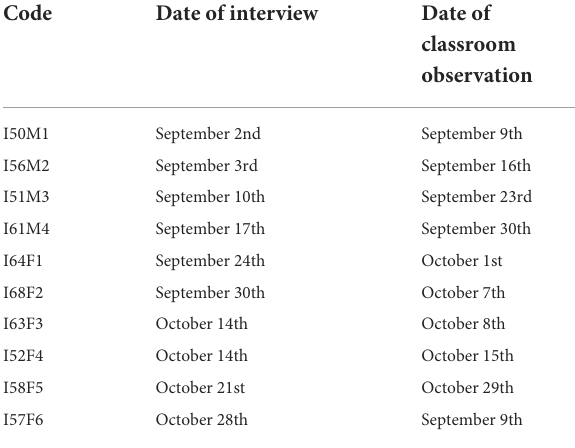
TABLE 3 Date of interview and classroom observation for each of the subjects